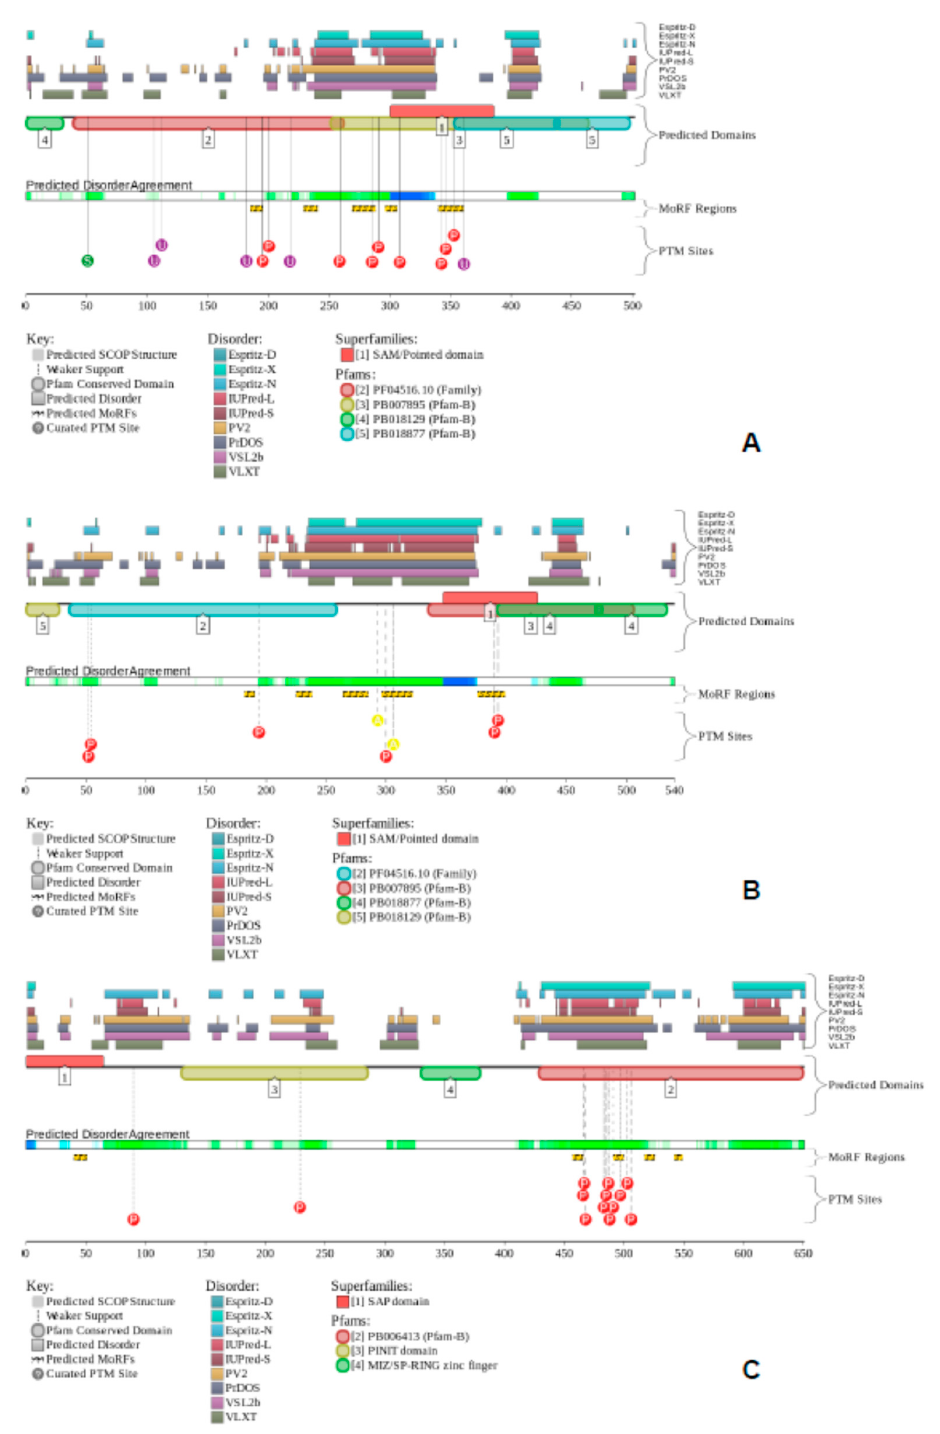
Figure 9. Intrinsic disorder predisposition of mouse CP2c (UniProt ID: Q9ERA0; ( A )), CP2b (UniProt ID:Q811S7; ( B )), and Pias1 (UniProt ID: O88907; ( C )). Functional disorder profiles were generated